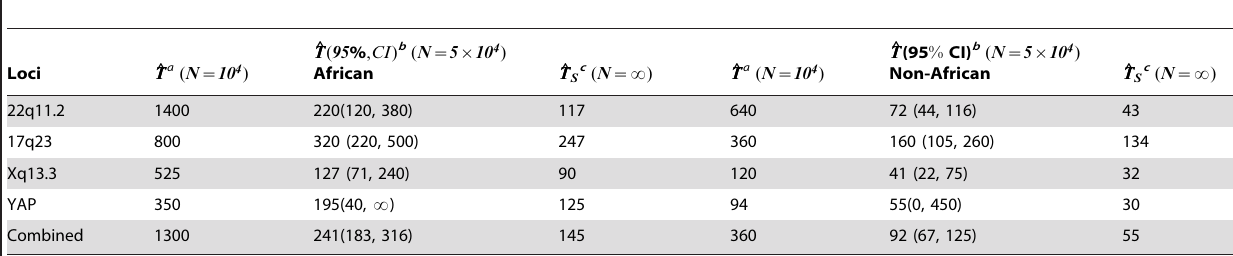
Table 2. Estimates for the elapsed times T since a recent homogenization event for each of the four loci.